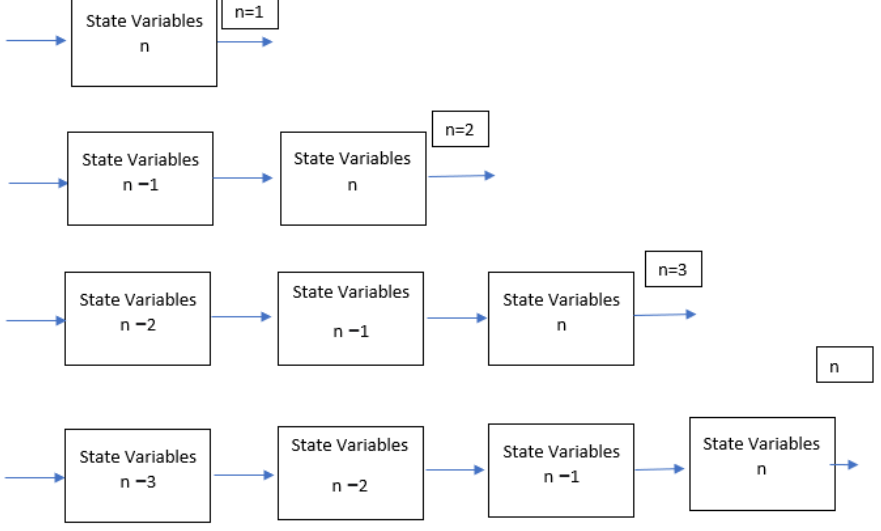
Figure 2. Mapping diagram of n manufacturing operations.